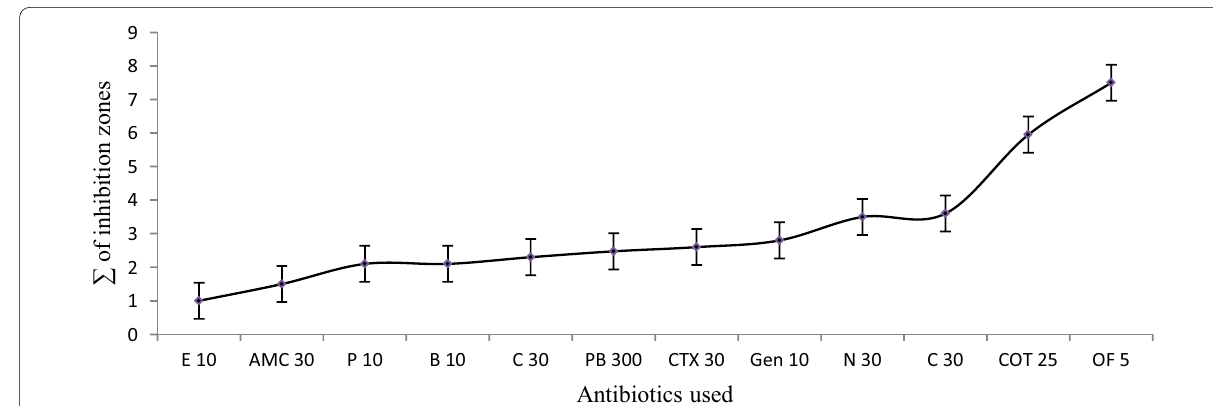
Fig. 4 Tolerance pattern (mean of replications) of PSMC isolates against some common antibiotics